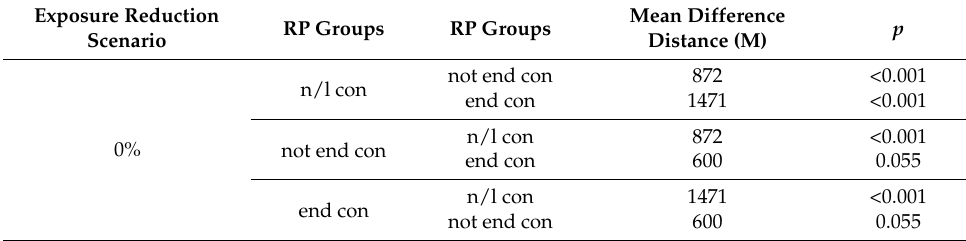
Table 4. Games–Howell post hoc test for in between group differences among risk perception (RP) groups and accepted distances to a base station for various exposure reduction scenarios. (n/l con = not and less concerned; not end, con = not enduringly concerned; endcon = enduringly concerned).